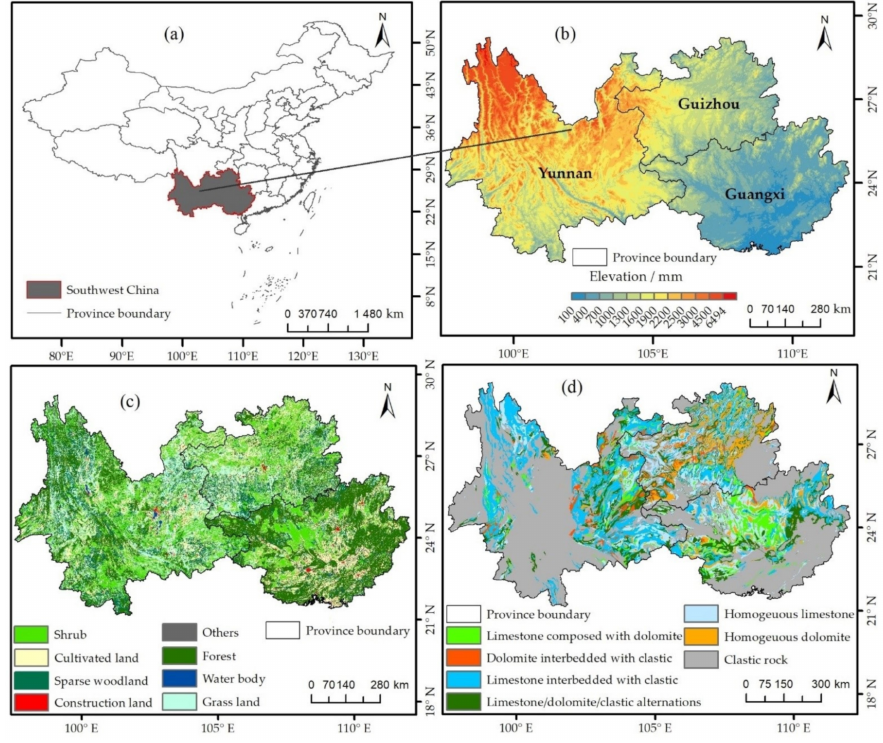
Figure 1. ( a ) The location, ( b ) elevation, ( c ) land use and cover, and ( d ) lithology of the study